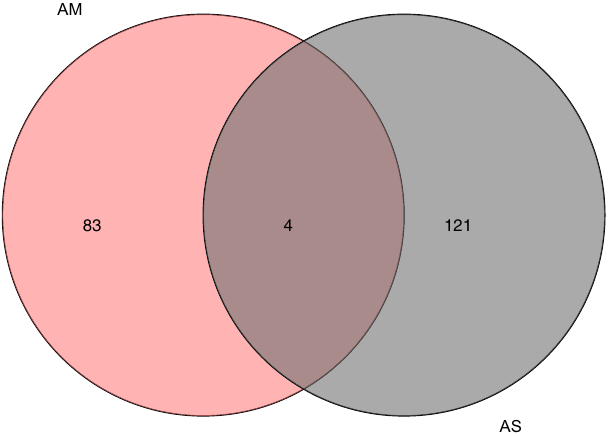
Figure 1. Venn of compounds’ screening. After preliminary screening, there are 87 components of AM, 125 components of AS, and 4 components shared by both AM and